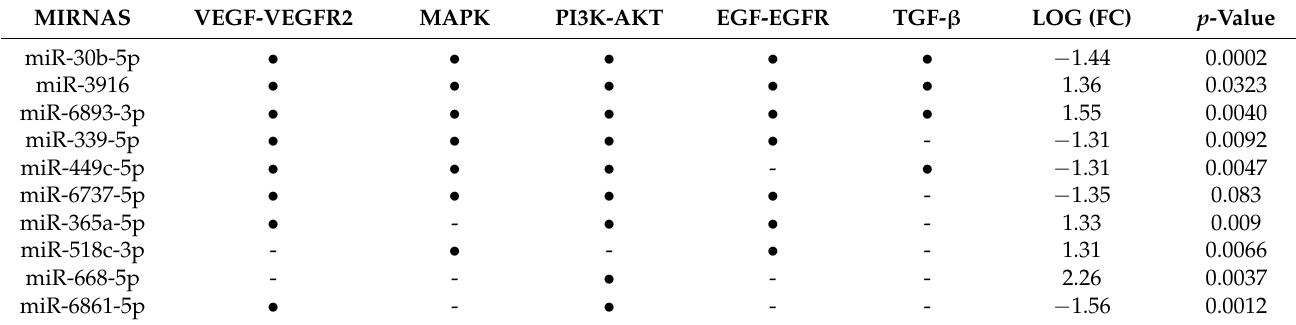
Table 3. Selected miRNAs from the array involved in the vascular remodeling pathways. “FC” represented 2 – ∆∆ Ct, and “Log (FC) > 0” means the gene was upregulated, while “Log (FC) < 0” means the gene was downregulated. FC indicates the fold changes of the microRNA (miRNA) expression in ISR as compared to non-ISR patients. “ • ” means that the miRNA participates in the corresponding signaling pathway. “-“ means the miRNA does not participate in the signaling pathway. Vascular endothelial growth factor and its receptor R2 (VEGF-VEGFR2), mitogen-activated protein transforming growth factor beta (TGF- β ).